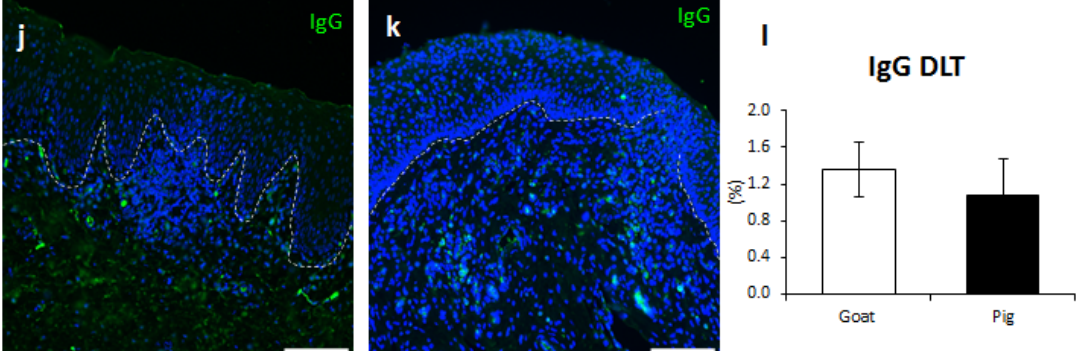
Figure 5. IgA + , IgG + plasma cell characteristics in GOALT of goat and pig. ( a , b ) IgA + plasma cells in the LN of goat and pig. ( c ) Positive percentage of IgA + plasma cells localized the LN. Values = mean ± SE. n ≥ 4. ( d , e ) IgA + plasma cells in the DLT of goat and pig. ( f ) Positive percentage of IgA + plasma cells localized the DLT. Values = mean ± SE. n ≥ 4. ( g , h ) IgG + plasma cells in the LN of goat and pig. ( i ) Positive percentage of IgG + plasma cells localized the LN. Values = mean ± SE. n ≥ 4. ( j , k ) IgG + plasma cells in the DLT of goat and pig. ( l ) Positive percentage of IgG + plasma cells localized the DLT. Values = mean ± SE. n ≥ 4. Dotted lines indicated the approximate boundary between LP and epithelium. Scale bars = 100 µ